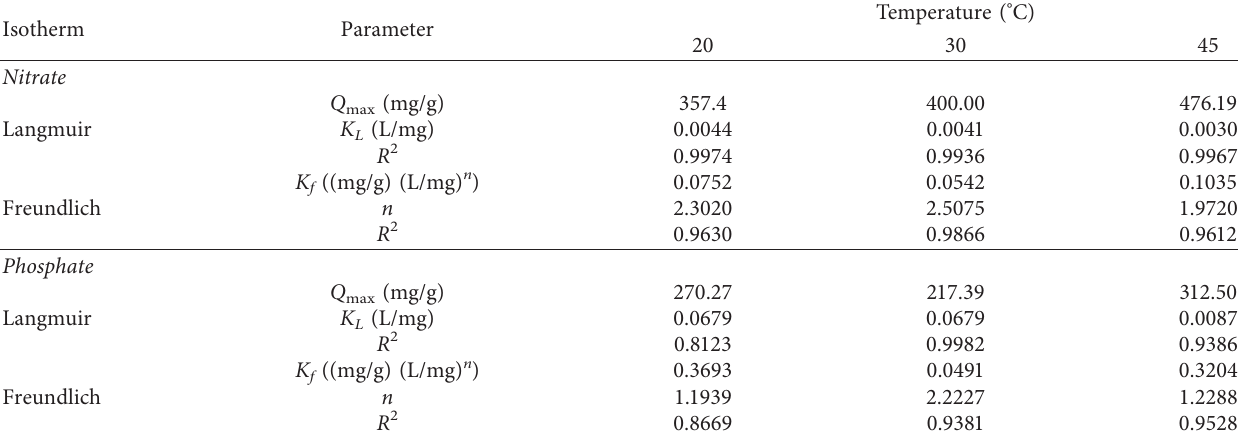
Table 2: The isotherm parameters of nitrate and phosphate adsorption onto ferric oxide-amine material.